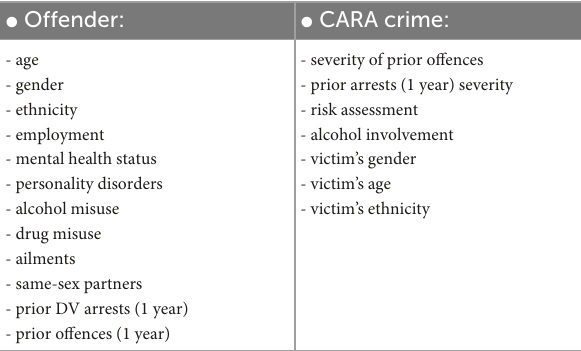
TABLE 3 West Midlands Police Data Descriptive Statistics - Means of offender crime characteristics.